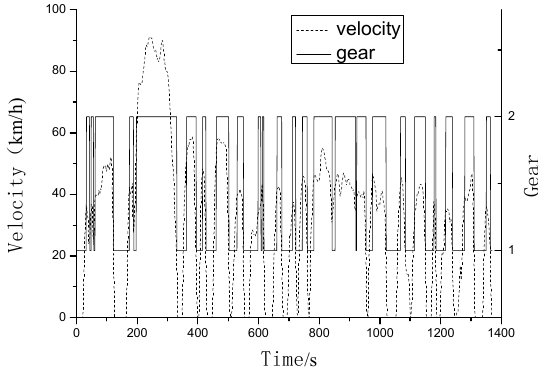
Figure 12. Gear control sequence. Table 3. Transmission efficiency comparison.